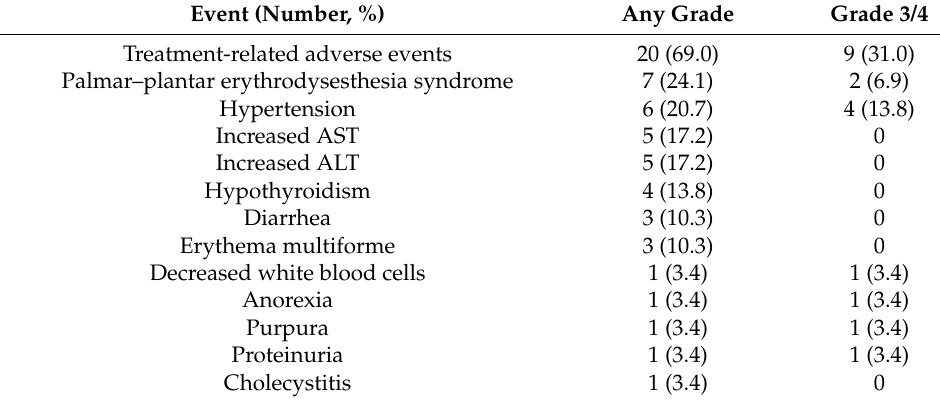
Table 4. Adverse events with targeted therapy after nivolumab and ipilimumab. Event (Number, %) Any Grade Grade 3/4 Treatment-related adverse events 20